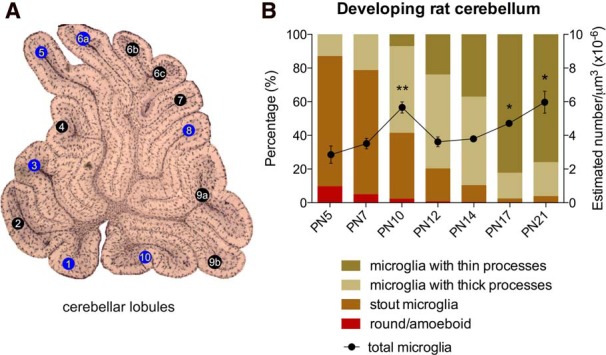
Postnatal microglia across the developing cerebellum. A, A sagittal view of the vermis showing the six lobules used to count microglia (blue background). B, The density of total microglia significantly increased by 1.58-fold in the third postnatal week compared with the first week (*p < 0.05, **p ≤ 0.01 compared with P5; data are expressed as mean ± SEM; n = 4, 2 males + 2 females for each group). Colored bars depict the proportion of microglia according to morphology at different time points during postnatal development: round/amoeboid microglia are present but infrequent during the first 10 postnatal days while stout microglia are strongly predominant during the first postnatal week, and microglia with both thick and thin processes are more abundant during the second and third week, respectively.